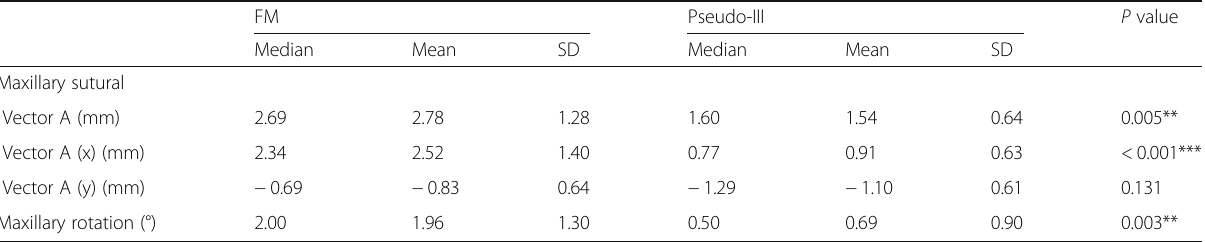
Table 1 Structural superimpositional measurements in the FM and pseudo-III groups